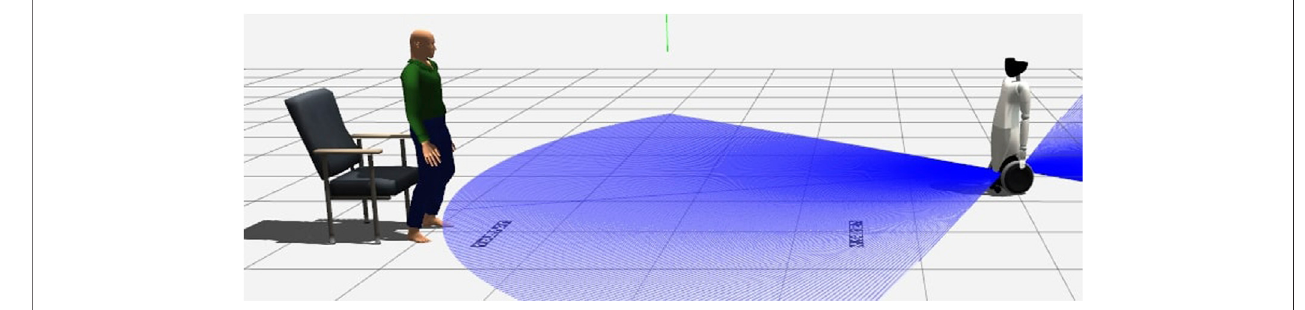
FIGURE 2 | The TUG developed in Gazebo.